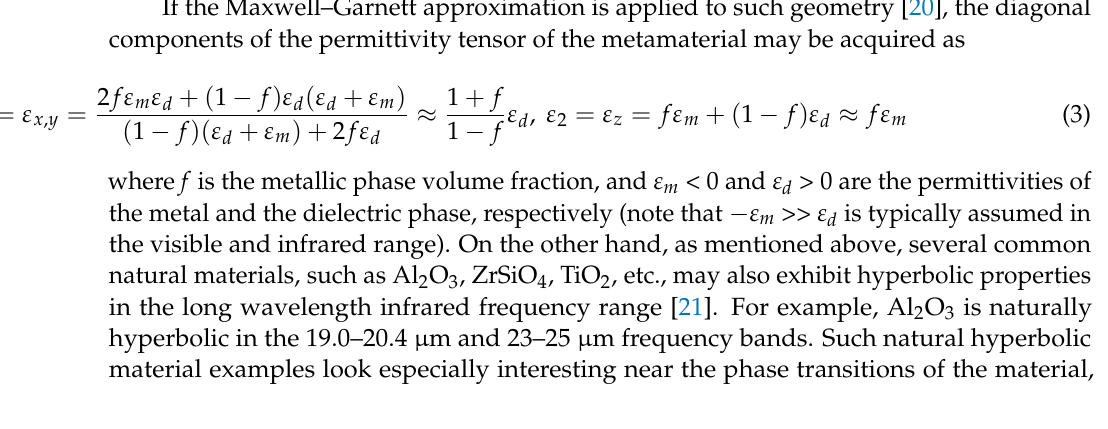
Figure 1. Typical geometry of a metal wire array hyperbolic metamaterial.